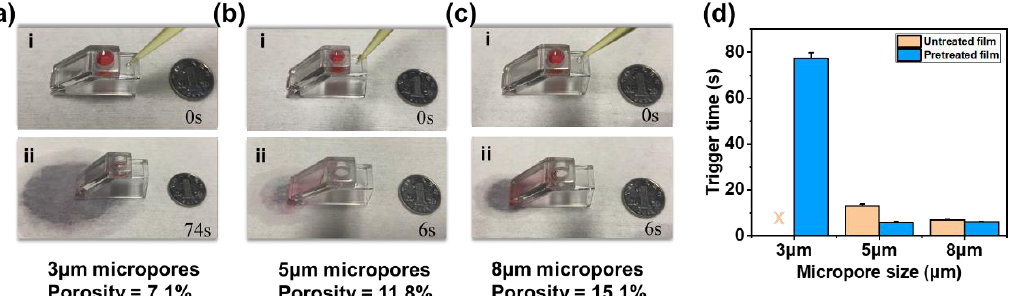
Figure 5. Trigger performances of the 3D trigger valve with different gating thresholds. ( a ) The trigger performance of the valve with the 3 µ m pore size. ( b ) The trigger performance of the valve with the 5 µ m pore size. ( c ) The trigger performance of the valve with the 8 µ m pore size. ( d ) Trigger performance of untreated and pretreated microporous membranes with different pore sizes.